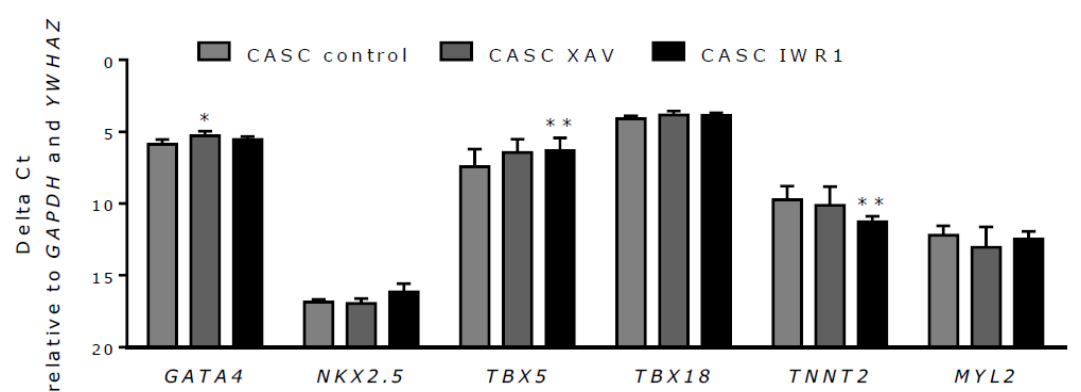
Figure 8. Wnt inhibition has a limited effect on CASC differentiation. mRNA expression levels of the cardiac differentiation markers GATA4 , NKX2.5 , TBX5 , TBX18 , TNNT2 , and MYL2 after treatment with XAV939 and IWR1-endo. Data are shown as medians ± IQR ( n = 6 individual patient CASC cultures/condition); * p < 0.05, ** p < 0.01 compared to respective control.